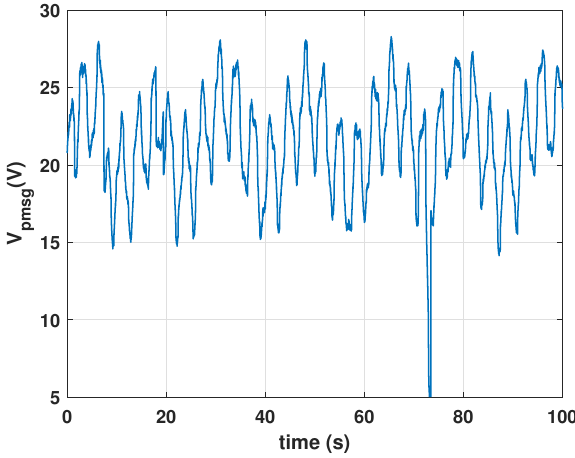
Figure 13. Output voltage of the